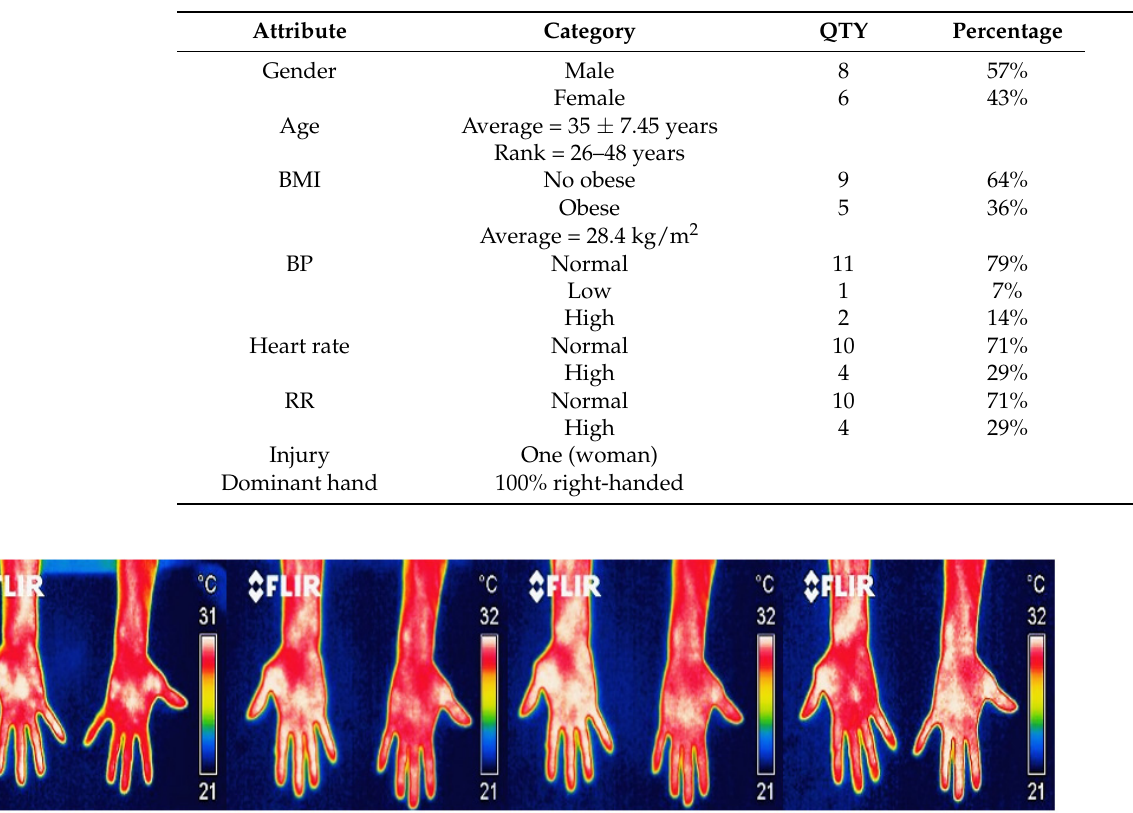
Figure 6. Thermogram from the back of the hand of one of the participants at moments 5 ′ , 10 ′ , 15 ′ , and 20 ′ .